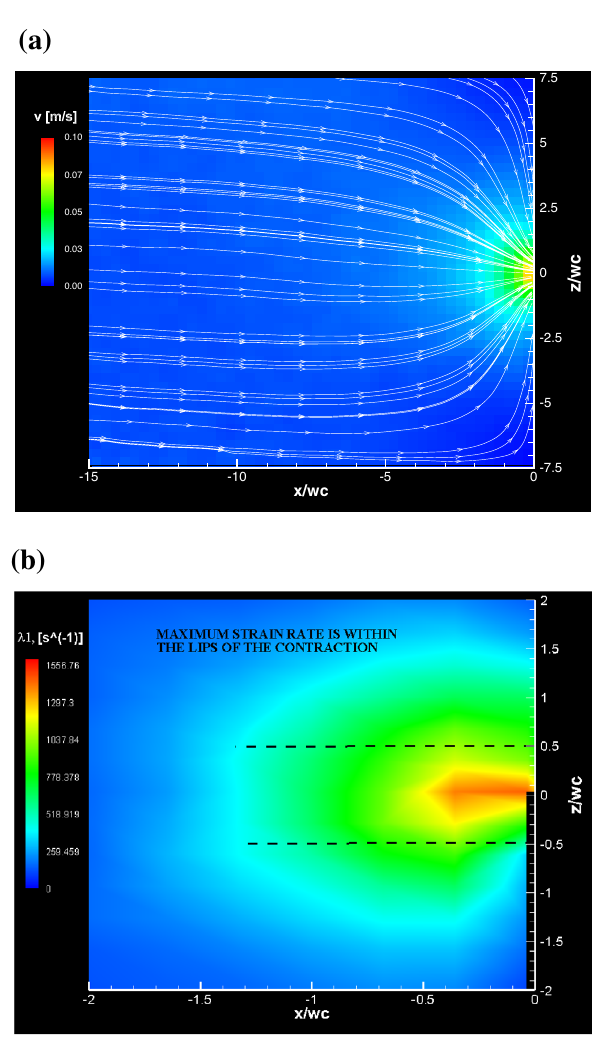
Fig. 5 Velocity field ( a ) and local strain field ( b ) for a Re = 0.09 , Pe = 0.24 flow of a 300 g/L BSA solution through a “26-G” microchan- nel. The origin ( x , z ) = ( 0,0 ) is located in the middle of the contrac-